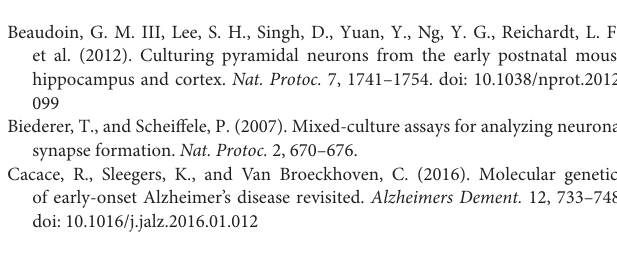
Supplementary Figure 1 | Cytokines are released by astrocytes after treatment with A β 42, A β 40, or LPS. Astrocytes were exposed to LPS (100 ng/ml), A β 40 (2.5 µ M), A β 42 (2.5 µ M), or A β 42scr (2.5 µ M) as control for 24 h. Cleared cell culture supernatant of astrocytes was assessed for abundance of secreted cytokines with the Mouse Cytokine Array. Detection of cytokine expression was performed by chemo-luminescence. (A) Representative membranes with dot blots in duplicate for every chemokine/cytokine for each condition are displayed. Note the significant upregulation of several cytokines upon treatment. Quantification of relative upregulation compared to control treatment of selected cytokines is shown in Figure 7 . (B) Representative identification of blotted chemokines/cytokines in astrocytes treated with A β 42 using the assay template. (C) Reference table of coordinates for cytokine quantification, according to the manufacturer. Supplementary Table 1 | Technical